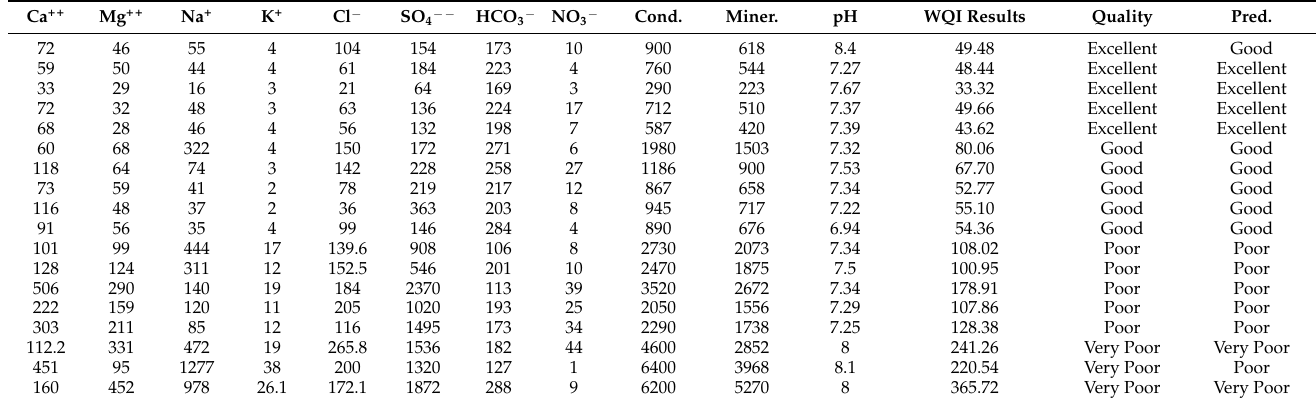
Figure 6. The ROC result of the ensemble bagged tree. Table 6. The prediction results of the 18 testing samples with linear